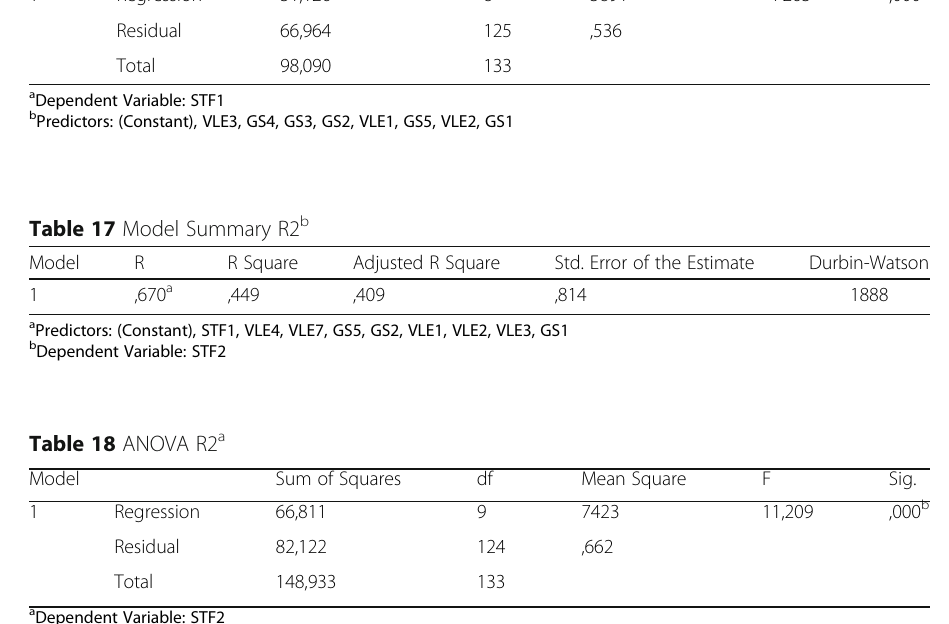
Table 16 ANOVA R1 a Model